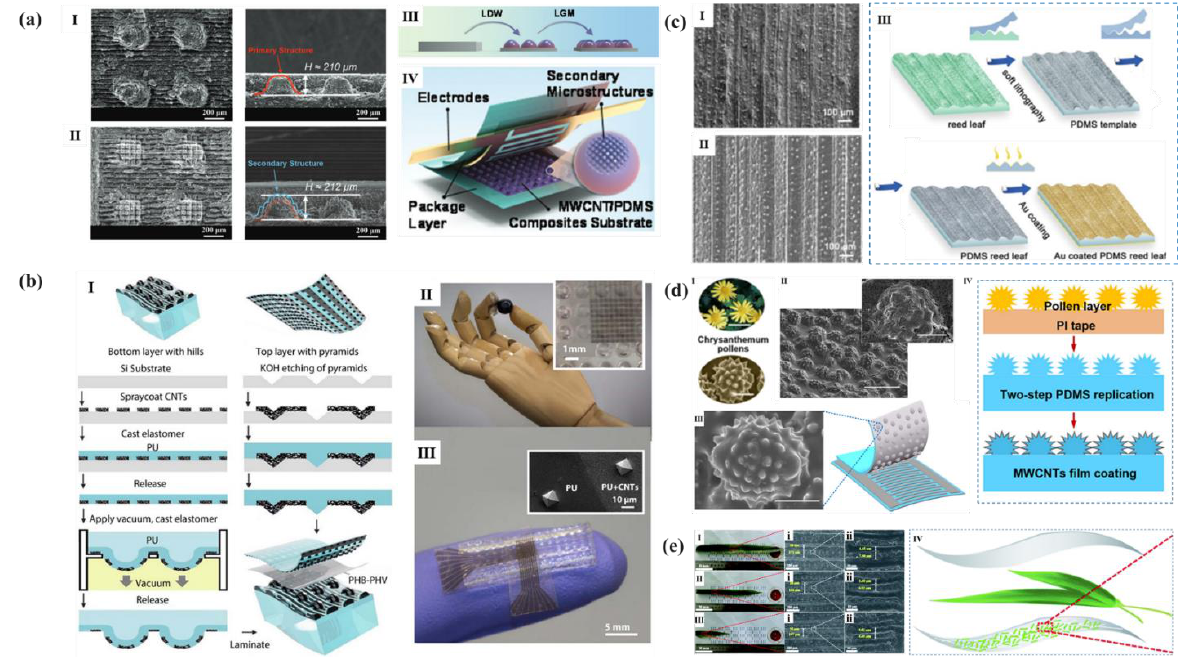
Figure 12. ( a ): Top and side views of SEM images of ( I ) SLMs and ( II ) HMs; ( III ) The sandwiched structure of the flexible piezoresistive sensor; ( IV ) fabrication of HMs [98]. ( b ) E-skin fabrication and appearance. ( I ) E-skin fabrication and assembly; ( I ) Optical image of a fabricated e-skin and close-up view on the hills and electrodes; ( III ) Optical image showing the CNT–PU interconnects for signal recording with LCR meter and SEM picture of the top e-skin layer with molded pyramids [99]. ( c , I ) SEM image of the natural reed leaf; ( II ) SEM image of the PDMS reed leaf; ( IV ) The fabrication of the micronanostructured capacitive sensor using a natural reed leaf as the template [100]. ( d , I ) Photograph of wild and SEM image of the hierarchical structure of the pollen grain; ( II ) Side-view SEM image of the hierarchical structure-patterned PDMS surface; ( III ) Schematic diagram of a piezoresistive sensor composed of MWCNT/PDMS with pollen-shaped hierarchical structures. ( IV ) Preparation process flow of the hierarchical structure-patterned film [101]. ( e ) Real photographs and corresponding SEM images of natural bamboo leaves at senile ( I ), mature ( II ), and infantile stages ( III ); ( IV ) Structure diagram of flexible pressure sensor [102]. Table 6. The summary of sensor performances with composite